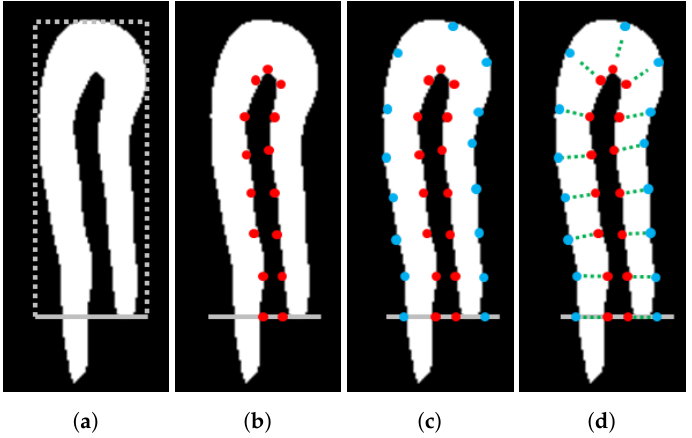
Figure 6. Example of capillary coordinate determination. ( a ) virtual rectangle determining capillary region of interest; ( b ) internal coordinates (red dots); ( c ) external coordinates (blue dots); ( d ) intermediate coordinates (green dots) between pairs of internal and external